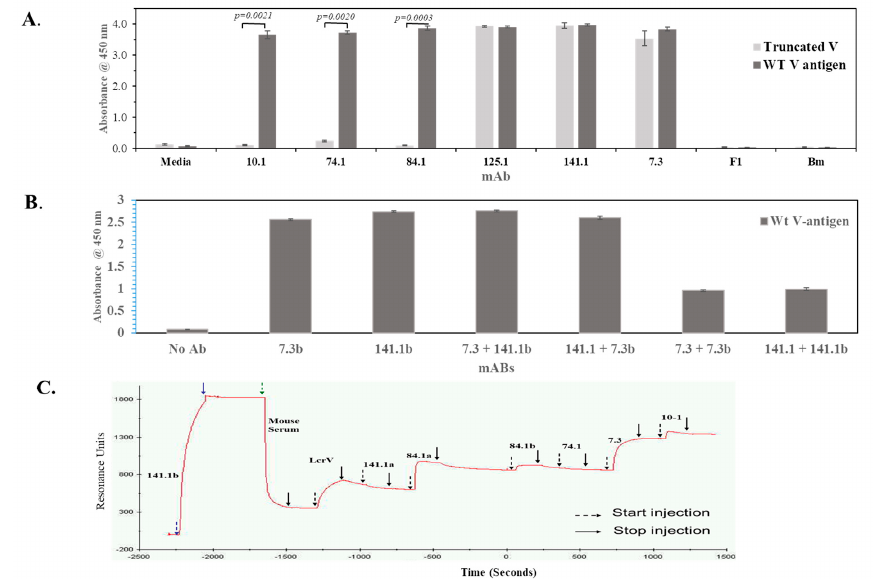
Figure 2. Binding of anti-V mAbs on the wild-type V-antigen or the truncated V-antigen. ( A ). The wild-type or truncated (135–275 amino acids) V-antigen were used at 10 µ g / mL, and the mAbs were used at 10 µ g / mL to examine binding. Negative control mAbs used were anti-F1 capsule and anti- B. mallei , besides without any anti-V mAb (media only). This assay was done twice in triplicate, and a representative assay is shown. Significant di ff erences were only seen between the amount of binding between the wild-type V-antigen and truncated V-antigen with mAbs 10.1, 74.1, and 84.1, but not with mAbs 7.3, 141.1, and 125.1. ( B ). Competitive binding was performed to assess if mAb 7.3 and 141.1 bound to the same site on the V-antigen. The wild-type V-antigen was used at 2 µ g / mL, and each mAb was added at 0.1 µ g / mL whether it was single or with another mAb. The secondary detection antibody was a streptavidin conjugated HRP to measure the amount of biotinylated mAb bound to the V-antigen. The b added to the mAb designates it as a biotinylated mAb (141.1b or 7.3b). This assay was done twice in triplicate. Comparisons were made between the amount of binding of mAb 7.3b and with that of the other mAb and combinations. All were significantly di ff erent ( p < 0.0001 ) except with 141.1 + 7.3b. ( C ). Surface plasmon resonance (SPR) analysis was used to examine binding of mAb 141.1 and 7.3 on the V-antigen. The mAb 141.1b (su ffi x b, for biotinylated) was first captured by a polyclonal anti-mouse Fc γ that was immobilized on a CM5 sensor chip. After blocking the complex with normal mouse serum, the V-antigen (100 nM) was captured by mAb 141.1b immobilized on the chip. Subsequently, other mAbs both biotinylated and unbiotinylated (designated with the su ffi x, a) (200 nM) were injected in succession without regeneration between mAbs. The SPR binding analysis was performed once. E ffi cient binding of mAb 74.1 to the V-antigen was not detected in the SPR assay (see Figure